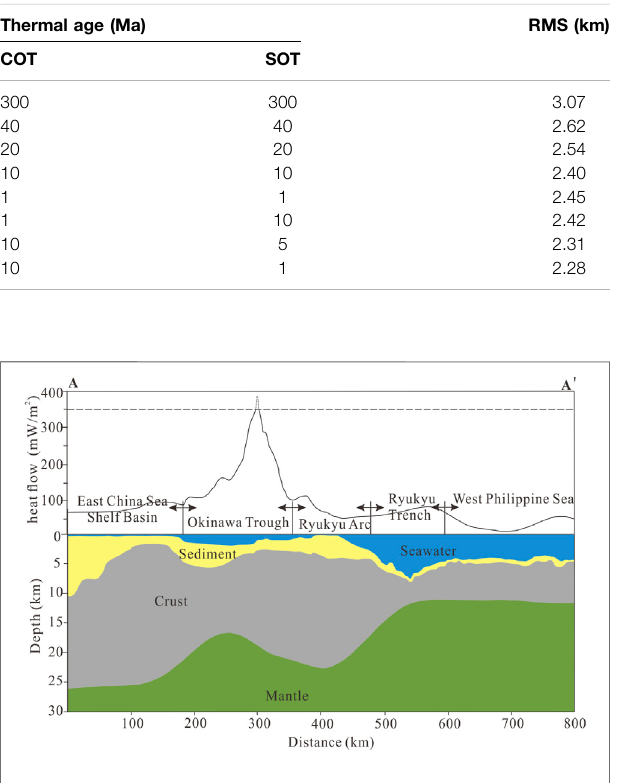
FIGURE 7| The crustal structure and the heat fl ow along the pro fi le AA ′ ; pro fi le location is shown in Figure 5A . The bathymetry is from ETOPO1, the sediment thickness is extracted from the data shown in Figure 2 , and the Moho geometry is from our gravity inversion. The heat fl ow data are extracted from the global heat fl ow database of the International Heat Flow Commission. The dashed part of the heat fl ow curve represents that the heat fl ow here is much higher than 350 mW/m 2 .